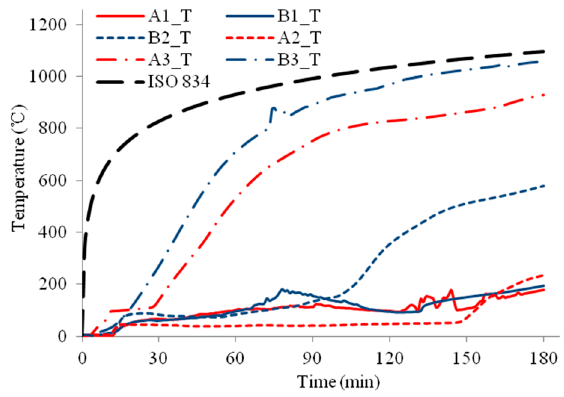
Figure 13. Temperature profiles at the medium section for HSS-C3.